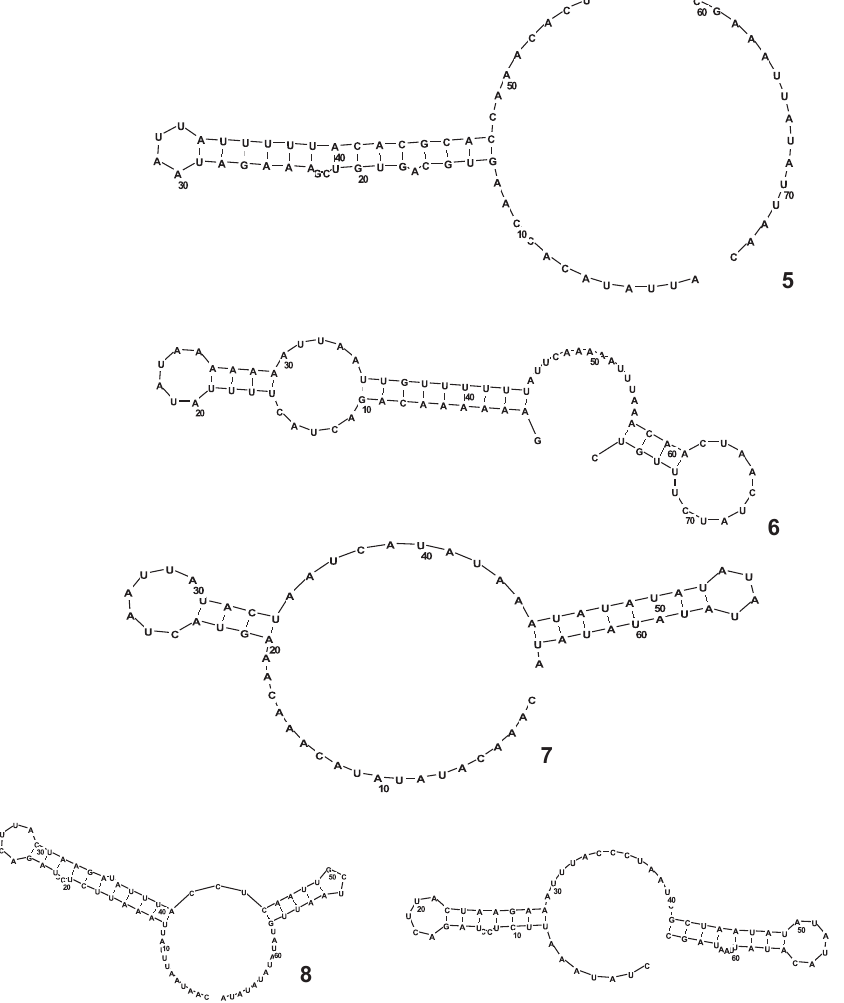
Figure 5-9. Secondary structure of repeat units constructed from VNTRs of the five pleurodiran turtles: (5) the 74 bp repeat unit of C. rugosa ; (6) the 76 bp repeat unit of C. fimbriata ; (7) the 65 bp repeat unit of P. subrufa ; (8) the 69 bp repeat unit of P. expansa ; (9) the 66 bp repeat unit of P. unifilis